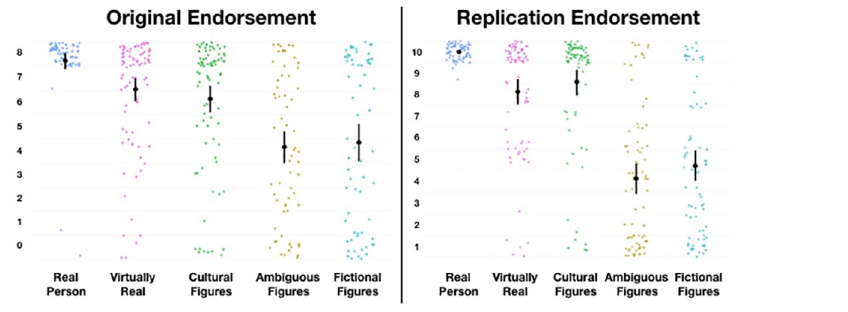
Fig 8. Plot of original vs replication endorsement values for categories.